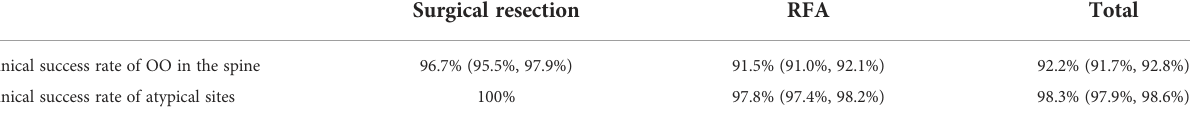
TABLE 4 Results of pairwise comparison of outcome measures in each group.